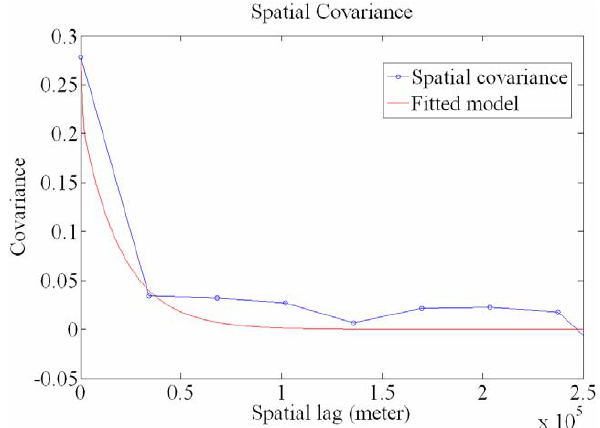
Fig. 5. Covariance values obtained from the fitted and the experimental models based on the residuals from ANFIS.